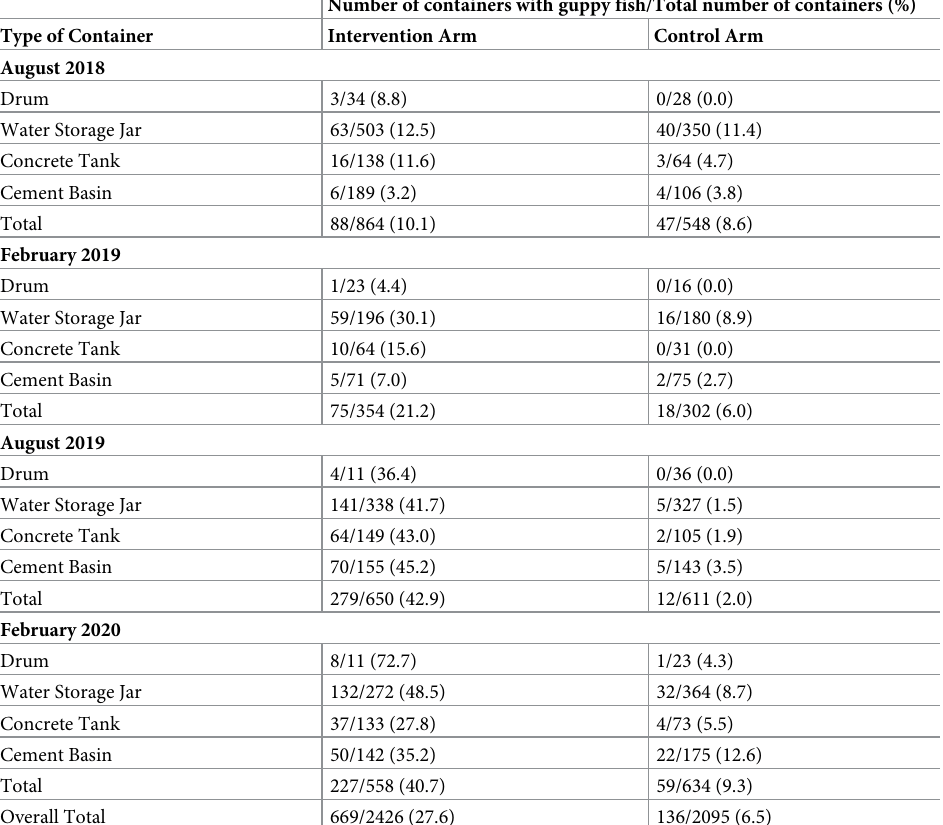
Table 5. Proportion of eligible water containers containing guppy fish, by container type, study arm and survey time point. Number of containers with guppy fish/Total number of containers